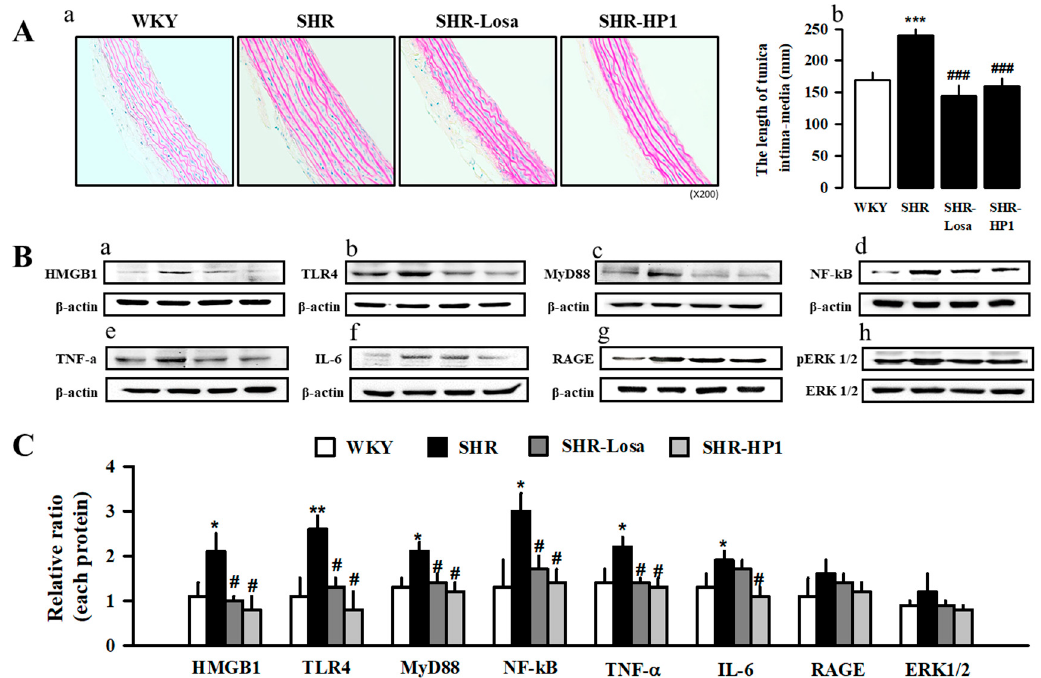
Figure 6. E ff ect of HP1 on thoracic aorta remodeling in SHRs. Histological changes in the thoracic aorta after HP1 administration to SHR. Representative images of hematoxylin and eosin (H&E) staining in the thoracic aorta of HP-1-treated in SHRs ( Aa ). Thoracic aorta ring media thickness in the indicated treatment groups ( Ab ). E ff ects of HP1 on the expression levels of HMGB1-TLR4-NF κ B signaling in the thoracic aorta from SHRs. The protein expressions of HMGB1, TLR4, MyD88, NF κ B (p65), TNF-a, IL-6, RAGE, and ERK1 / 2 were measured by Western blot analysis in thoracic aorta from each group ( Ba – h ). The bar represents the relative protein quantification of proteins based on β -actin ( C ). WKY, Wistar-Kyoto rat; SHR, spontaneously hypertensive rat; Losa, losartan; and HP1, Vitis labrusca leaves extract; HMGB1, high mobility group box 1; TLR4, toll-like receptor 4; MyD88, myeloid di ff erentiation primary response 88; NF κ B, nuclear factor kappa-light-chain-enhancer of activated B cells; TNF- α , tumor necrosis factor alpha; IL-6, interleukin-6; RAGE, receptor for advanced glycation end products; and ERK1 / 2, extracellular signal-regulated kinases. The values represent the means ± standard error ( n = 4 for each group). * p < 0.05, ** p < 0.01, *** p < 0.001 vs. WKY; # p < 0.05, and ### p < 0.001 vs. SHRs.